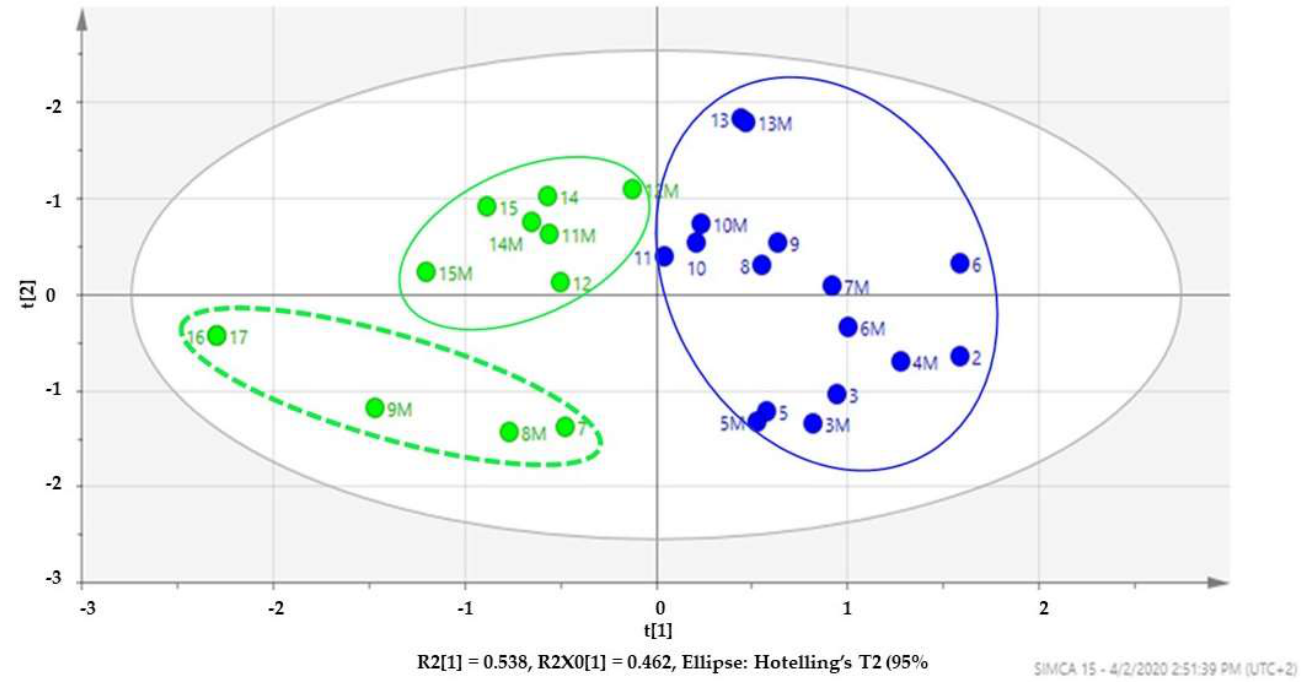
Figure 5. OPLS-DA Score scatter plot revealing two clusters (blue and green) of compounds present in the acetone and methanol extract. Numeric = acetone extract and alpha-numeric = methanol extract.